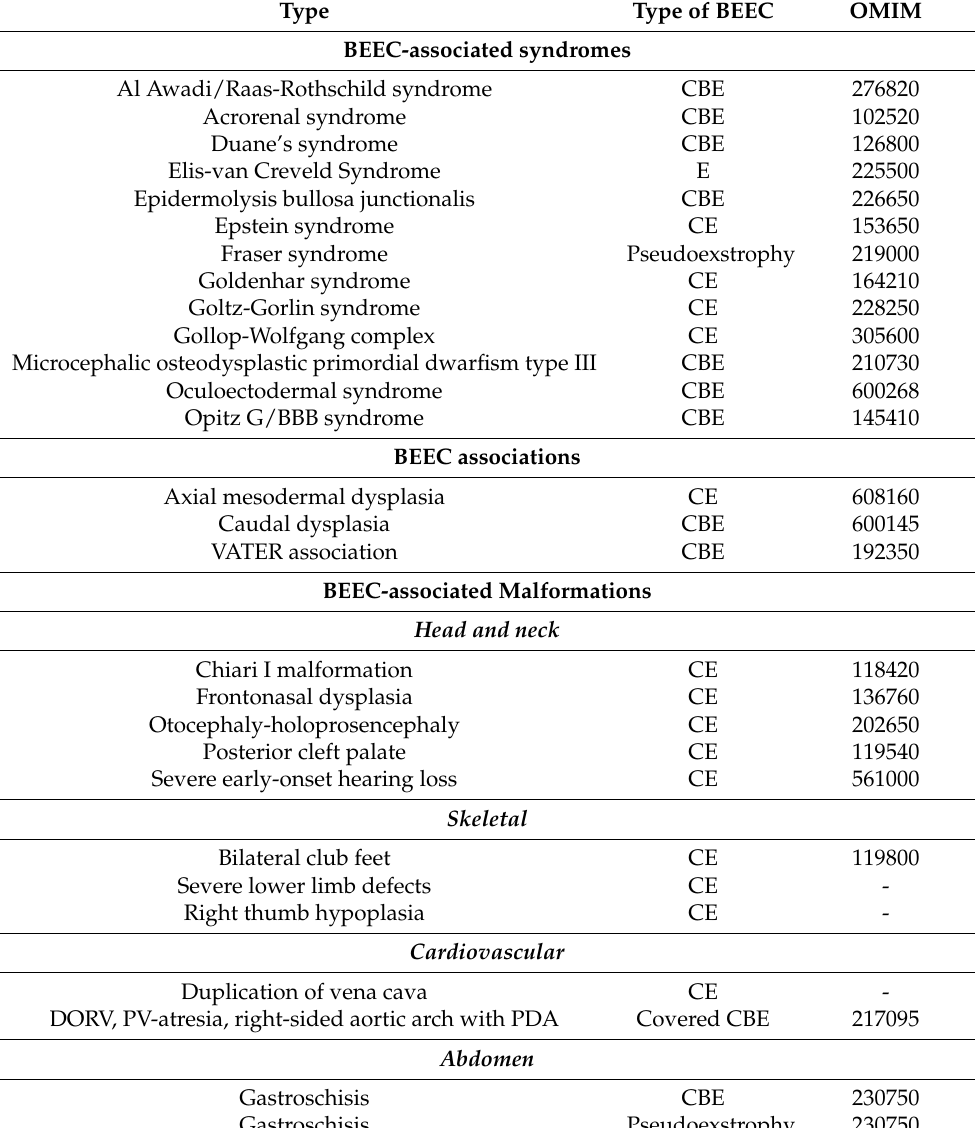
Table 1. BEEC and associated birth defects adapted from Ludwig et al., 2009